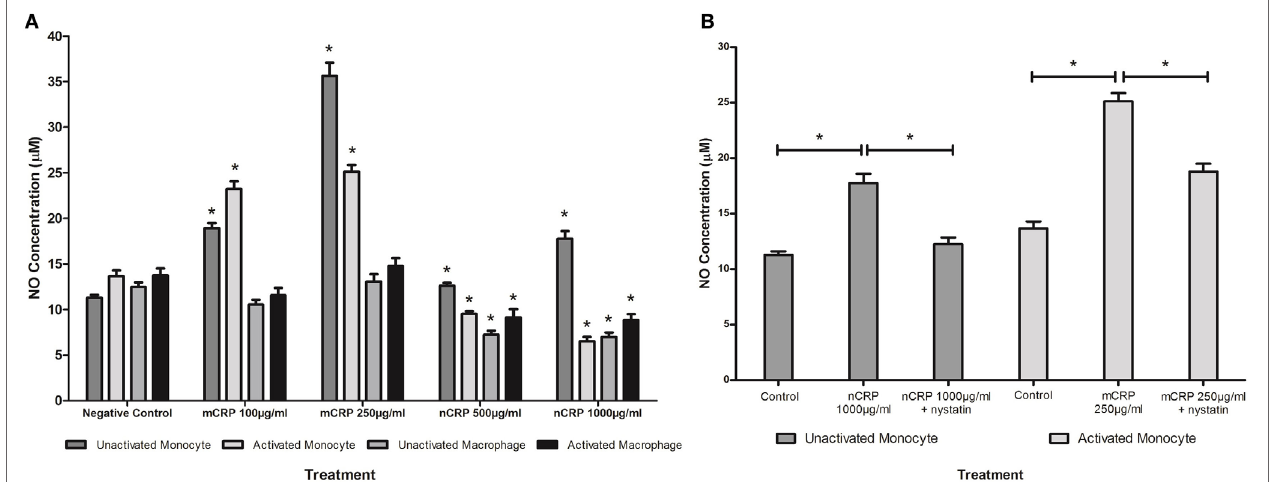
FigUre 4 | Effect of C-reactive protein (CRP) isoforms on nitric oxide (NO) production. NO production by several cell states (monocyte, lipopolysaccharide (LPS)-activated monocyte, macrophage, and LPS-activated macrophage) was differentially mediated by CRP isoforms in a concentration-dependent manner (a) . Nystatin significantly reversed CRP-mediated NO production in unactivated monocytes treated with native CRP (Ncrp) and activated monocytes treated with mCRP (B) . *Indicates significant differences ( P < 0.05; n = 12) in NO production compared with corresponding negative controls (a) or CRP/nystatin treatments (B) . Errors bars represent the